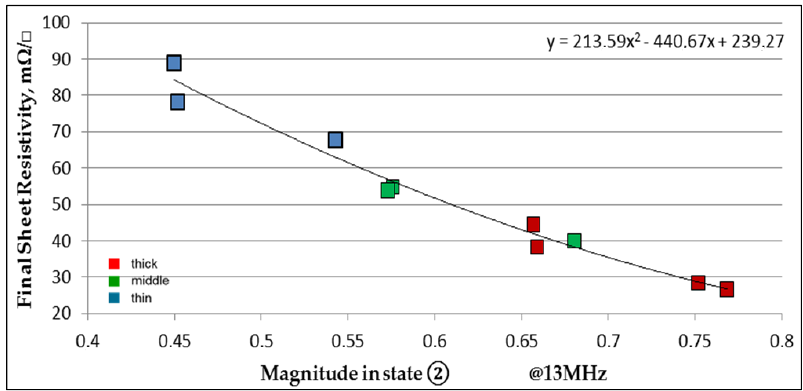
Figure 14. Correlations between the final sheet resistivity and the magnitude in state (2) at a frequency of 13 MHz for Cu/Ag films on CFRP substrate with coated area of 4 cm × 4 cm.